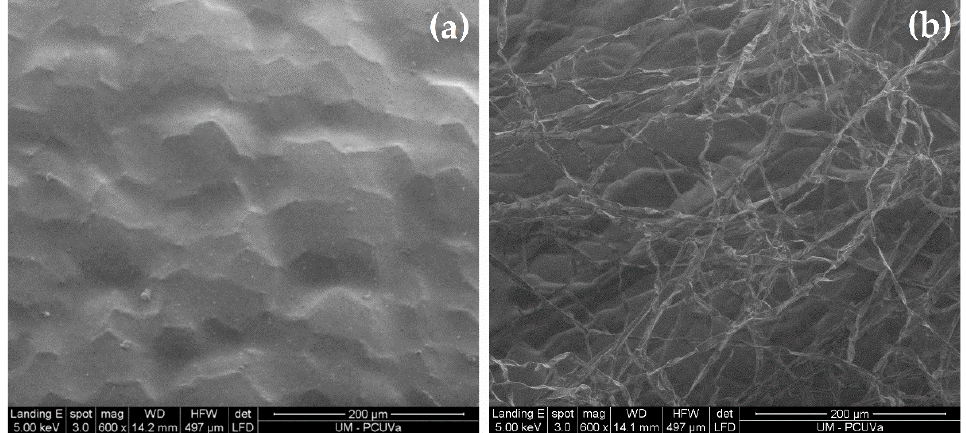
Figure 7. Scanning electron micrographs illustrating a comparison between strawberry fruits 10 days after artificial infection with B. cinerea : ( a ) treated fruits showed a smooth surface with no hyphal colo- nization, while ( b ) infected fruits showed the presence of numerous somatic hyphae on their